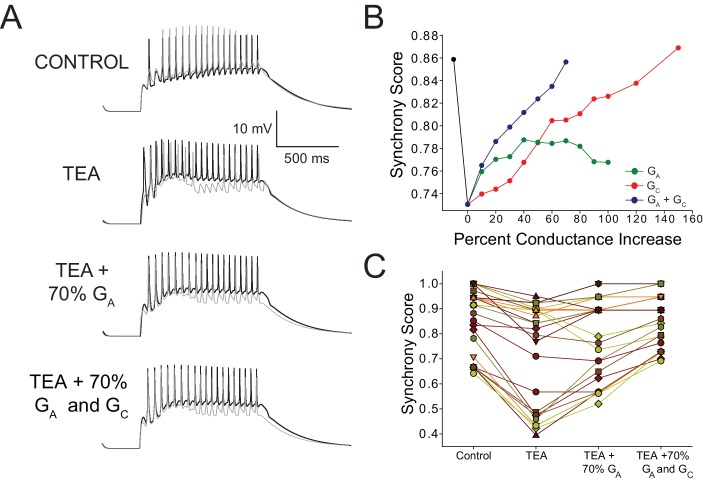
Increased GA and coupling conductance (GC) among LCs act in concert to help restore synchrony across LCs in model networks.(A) Voltage response of a typical network LC3 (gray) and LC4 (black) cells under three model conditions: control, TEA (90% reduction in both GKd and GBKKCa), TEA + 70% increase in GA, and TEA + 70% increase in GA and GC. (B) Effects of increasing GA alone, GC alone, or both GA and GC on synchrony in model networks. Dashed lines represent simple linear regression fits to the points for each condition. Black line represents the change in synchrony from control to TEA. Points shown are the average values for N = 27 networks. (C) Summary of Synchrony Score shown for all 27 model networks. Stepwise changes are shown from Control, TEA, TEA + increasing GA by 70%, and TEA + increasing both GA and GC by 70% (the point at which maximal synchrony is restored as per the analysis in panel B). Individual points correspond to those used to generate averages in panel A at the 70% level to give an idea of the variability in the data set. Individual preparations are connected with lines to show trends across networks.